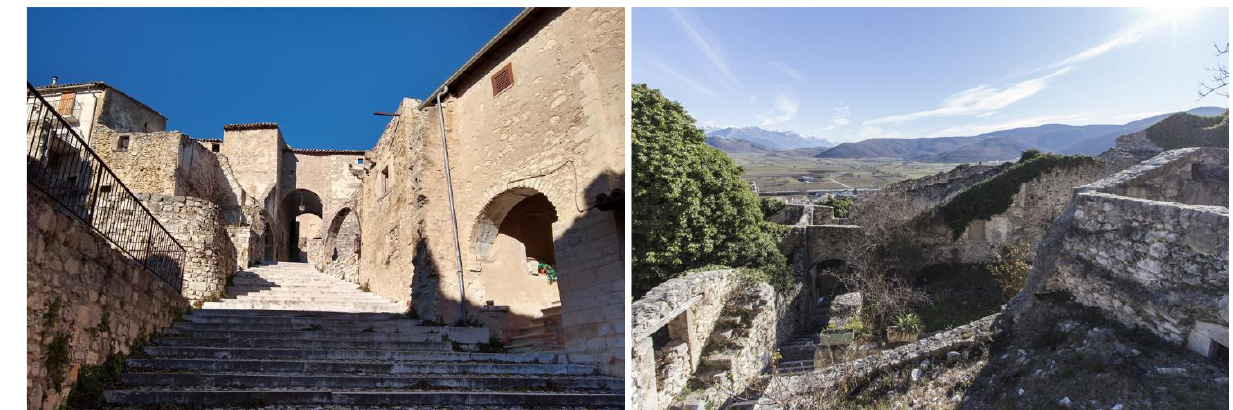
Figure 4. On the left: view of the main stairway; on the right: view of the site from the top of the